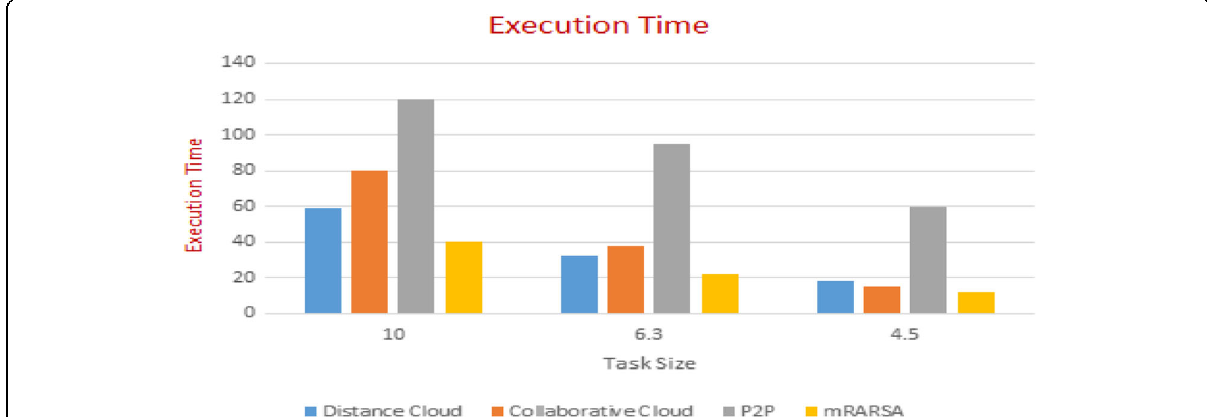
Fig. 12 Execution time performance evaluation graph. This graph represents the execution time performance against the utilization of the running cloud resources for second resource demanding Eight-Queen problem